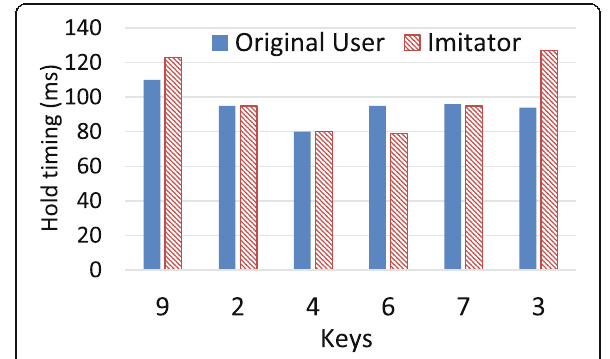
Fig. 11 Hold timings of an original user and the imitator